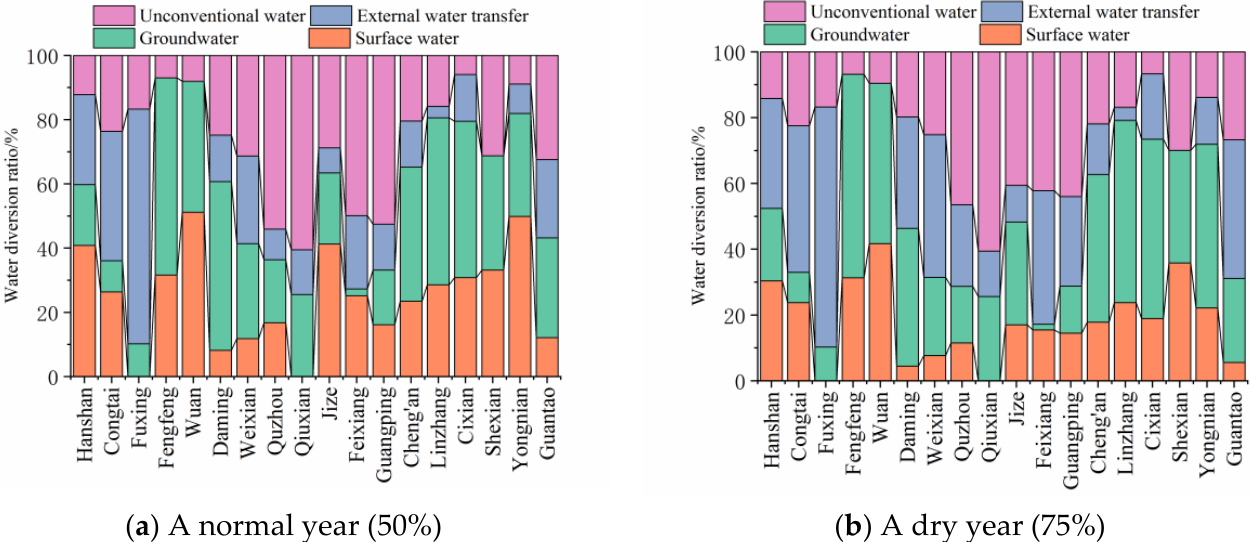
Figure 16. The structure of water supply source in 2035.